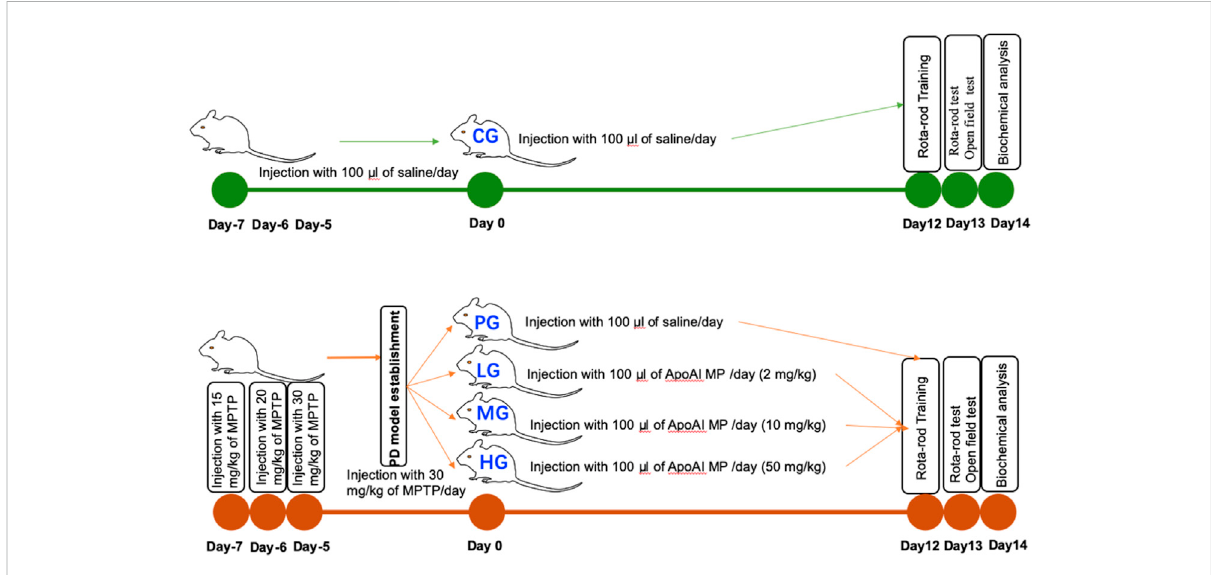
The study design of the present manuscript. Forty male mice were randomly divided into the control group (CG), the PD-model group (PG), low-dose ApoAI MP-treated group (20 mg/kg, LG), medium-dose ApoAI MP-treated group (100 mg/kg, MG), high-dose ApoAI MP-treated group (500 mg/kg, HG), and 8 mice in each